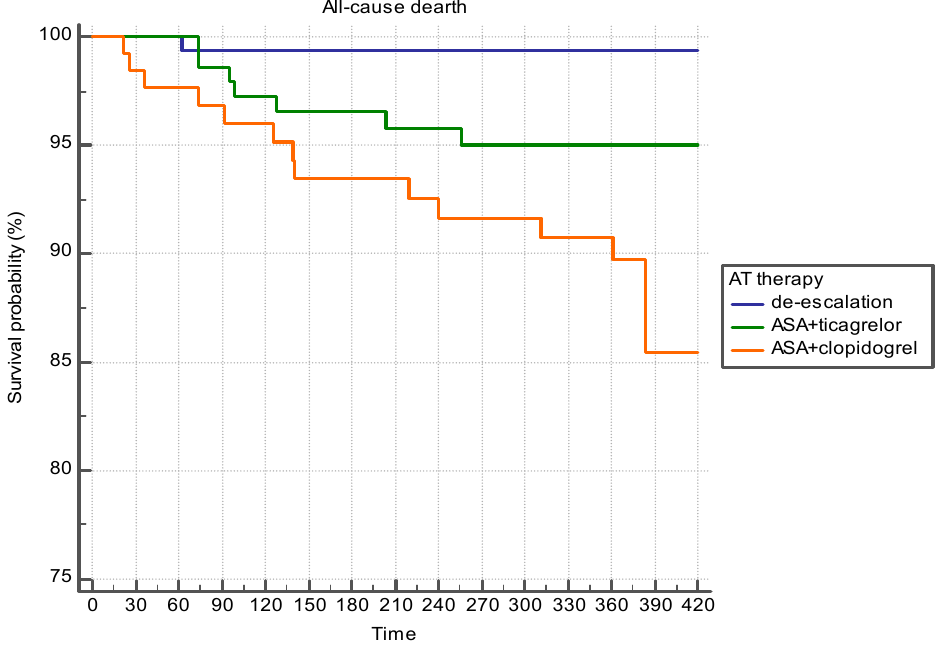
Figure 7. Survival probability depending on APT options after pseudorandomization (Kaplan – Meier analysis).